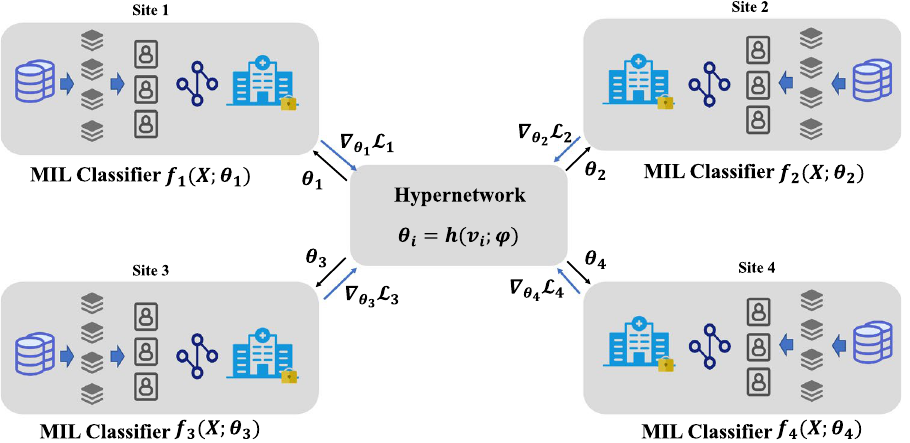
Figure 3. Federated learning with hypernetwork. Each local client has a MIL model, namely f 1 , f 2 , f 3 , f 4 , for whole slide image classification. On the server, a hypernetwork is used to generate the parameters of MIL classifiers. For parameter updates, the local client returns the gradient ∇ θ i L i over parameter θ i to the server. Then, the gradient ∇ ϕ θ i over ϕ is calculated to update ϕ . In this way, we can optimize the hypernetwork using all training data on local clients